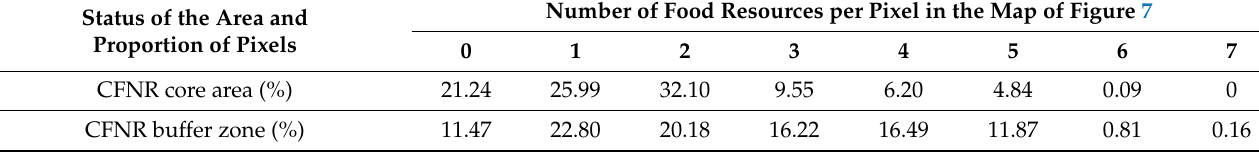
Table 4. Brown bear food resource richness in the Central Forest State Nature Reserve (CFNR) (West-European Russia) in 2008–2020 based on food-probability models classified by the maximum sum of sensitivity plus specificity (maxSSS)